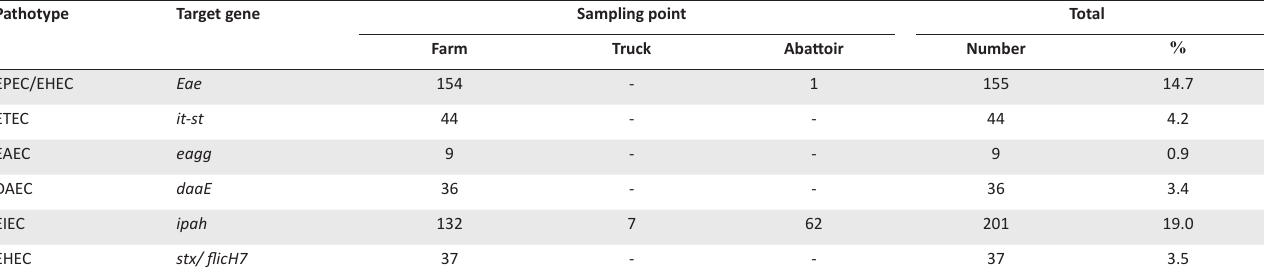
TABLE 1: Distribution of diarrheagenic E. coli pathotypes along the farm-to-fork continuum.